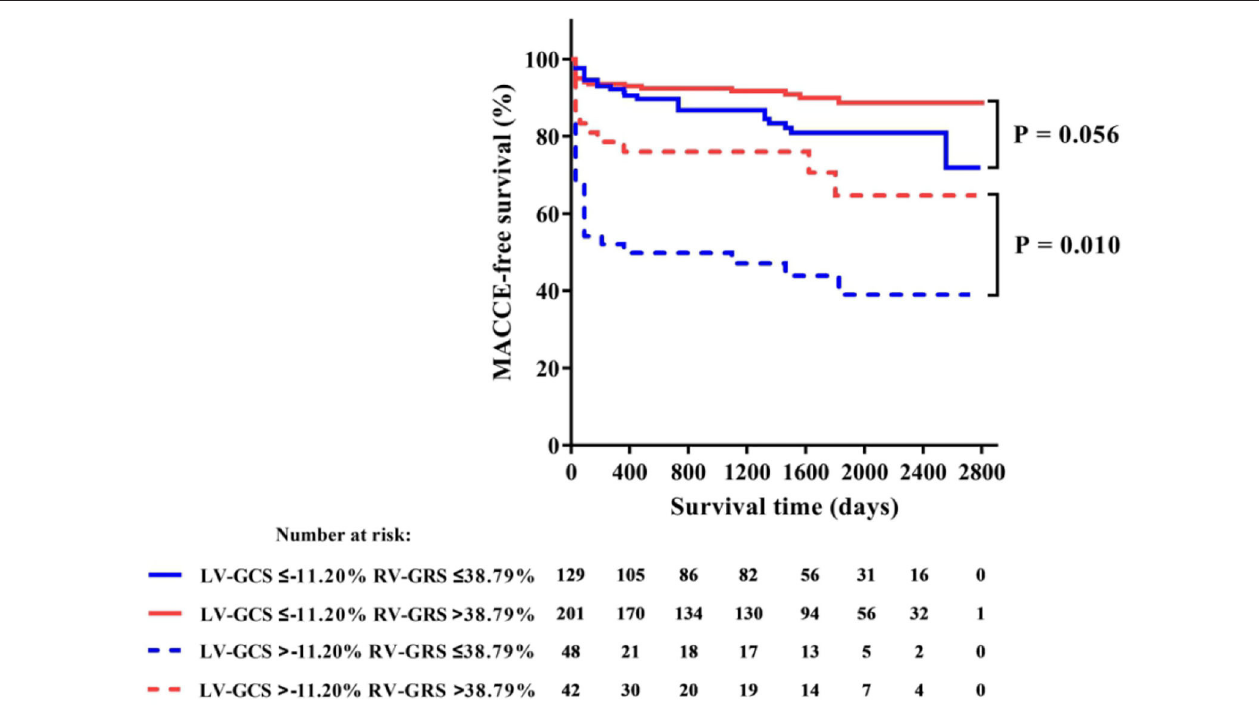
FIGURE 5 | Kaplan-Meier curve of MACCE-free survival in patients with or without concomitant impairments of LV-GCS and RV-GRS. GCS, global circumferential strain; MACCE, major adverse cardiac and cerebrovascular events; GRS, global radial strain.